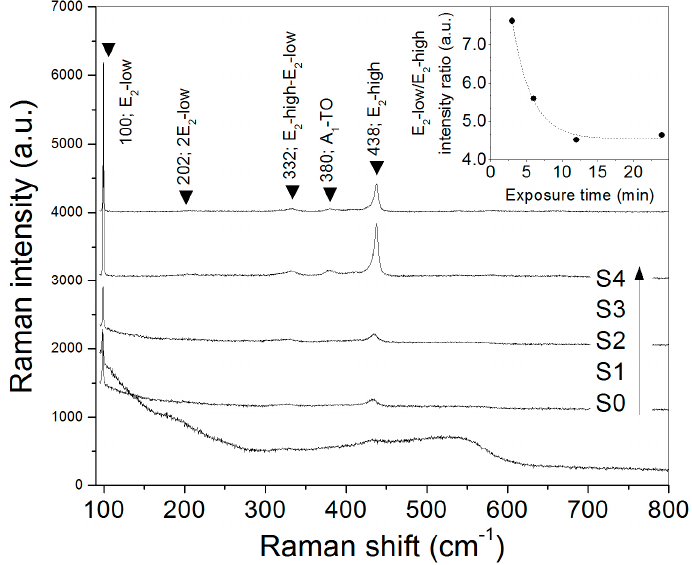
Figure 2. Raman spectra of the precursor powder (S0) and the products obtained after its thermal oxidation (900 ° C; air atmosphere) during different times: 3 (S1), 6 (S2), 12 (S3), and 24 min (S4). Inset: Dependence of E 2 –low/E 2 –high intensity ratio with the exposure time. Table 2. Elemental composition, UV/visible emission intensity ratio (I UV /I Vis ), and band gap energy ( E g ) of the different samples obtained by thermal